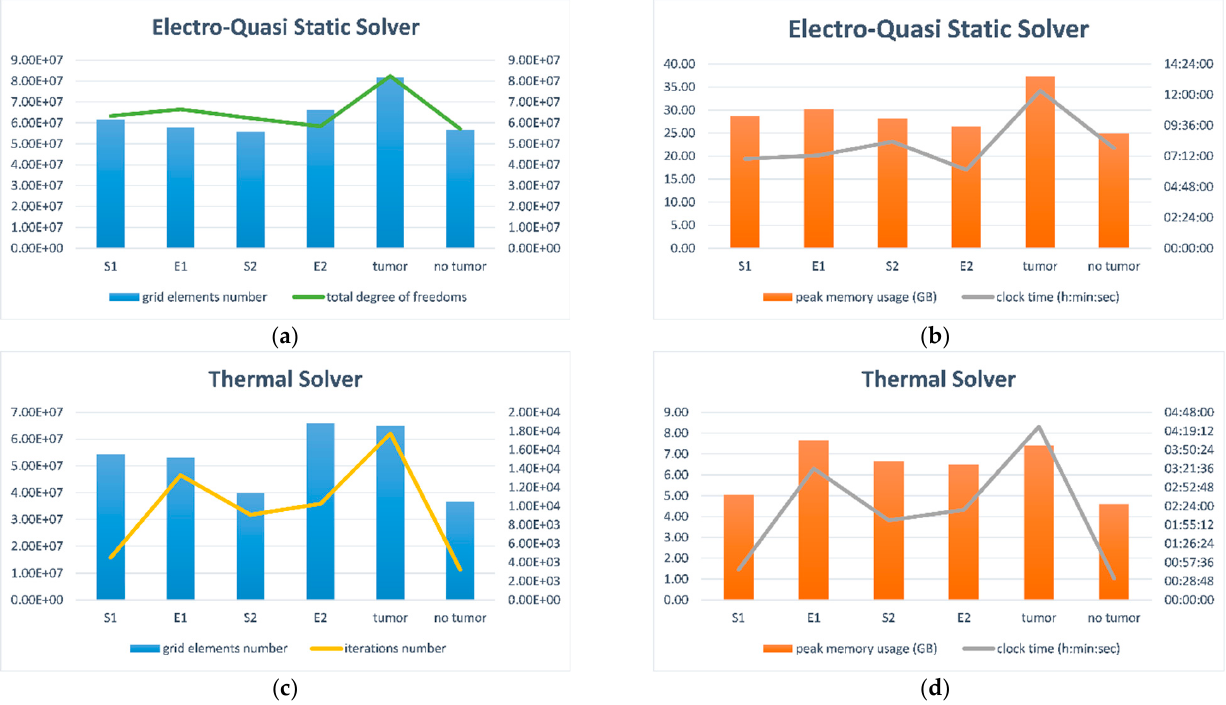
Figure 10. Grid element number, total degree of freedoms, peak memory usage, and clock time values for an electro-quasi- static solver ( a ) and ( c ); and a thermal solver ( b ) and ( d ) in the case of all analyzed tumor models.